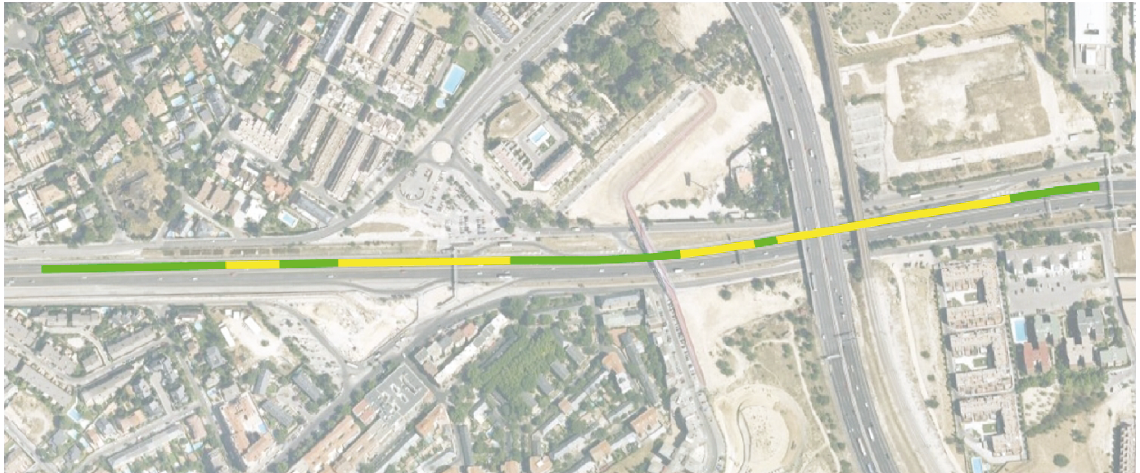
Figure 22: GPS trajectory and the corresponding tra ffi c load computed at the central unit (the aerial image has been obtained from Google